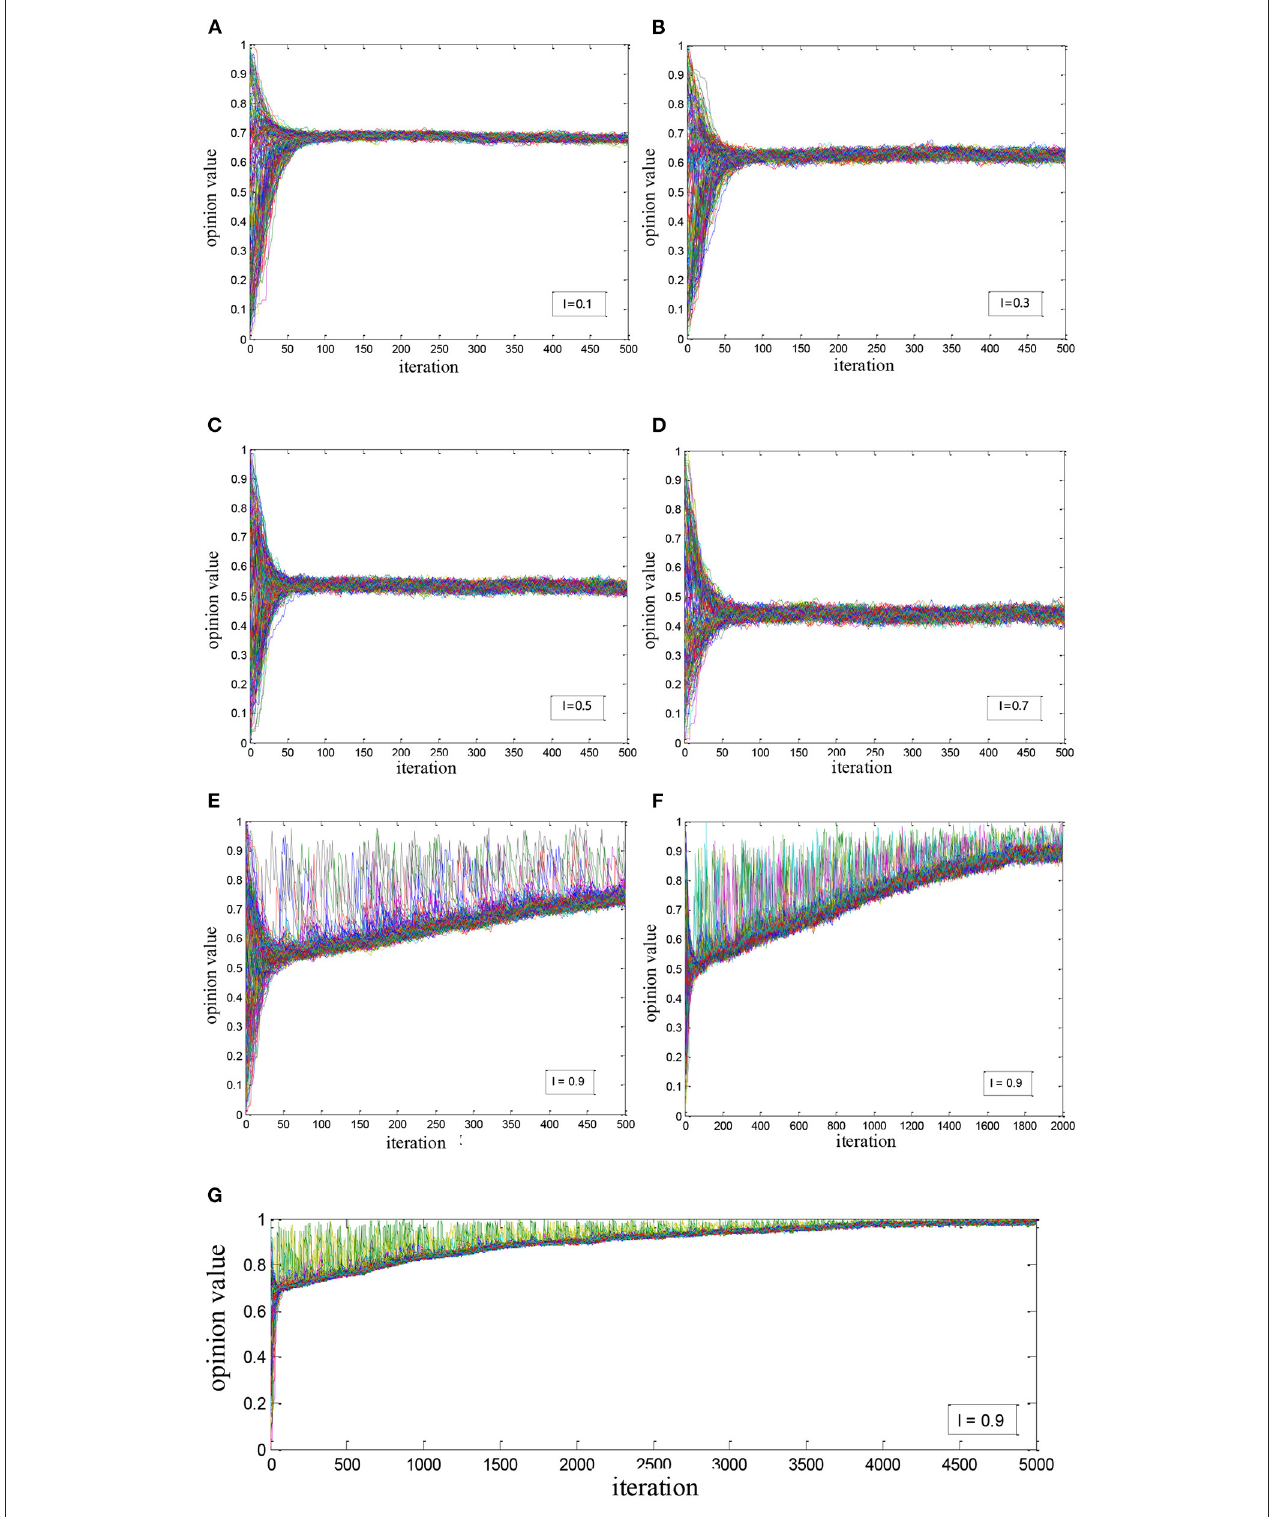
FIGURE 4 | Simulation of health opinion evolution considering the network noise: (A) I = 0.1; (B) I = 0.3; (C) I = 0.5; (D) I = 0.7; (E) iteration = 500; (F) iteration = 2,000; (G) iteration = 5,000.